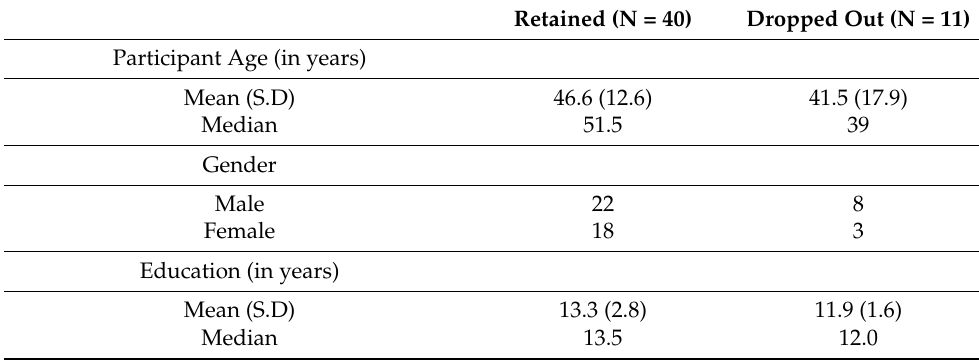
Table 1. Clinical and demographic characteristics of the sample at